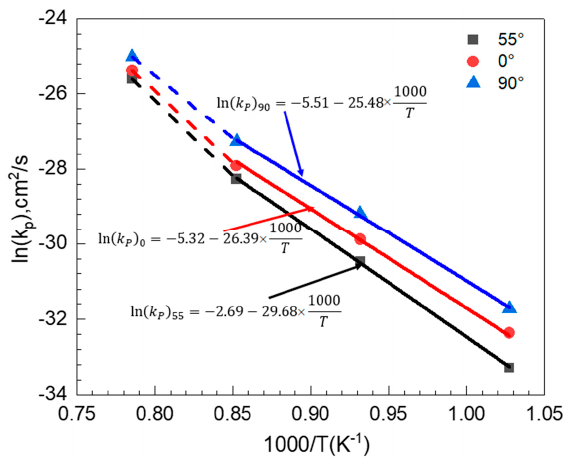
Figure 15. Arrhenius plot for the oxidation of EBM-In718 alloys.